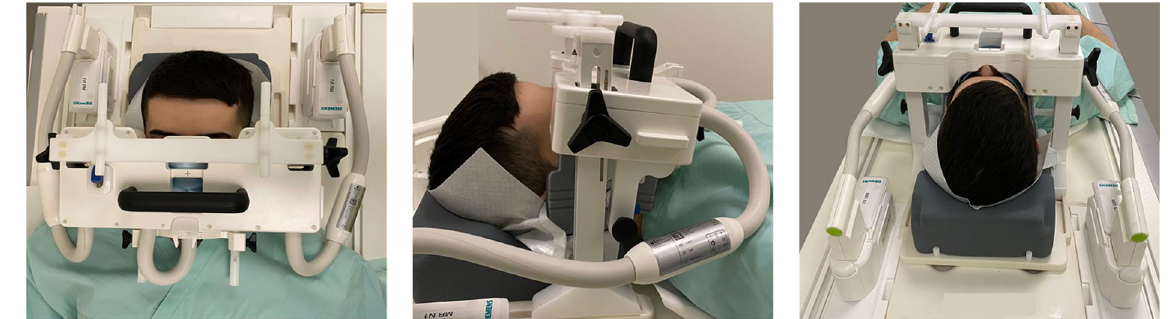
Figure 1. All study participants underwent 3 Tesla MRI (Skyra, release VE11e, Siemens Healthineers, Erlangen, Germany) using a dedicated 15-channels mandibular coil (NORAS MRI products, Hoechberg, Germany). The mandibular coil used in this study has a field of view of 32 × 16 × 16 cm 3 and is an optimized 14+ 1 receiver coil array and positioning system specifically designed for high-resolution imaging of dental structures in the oral